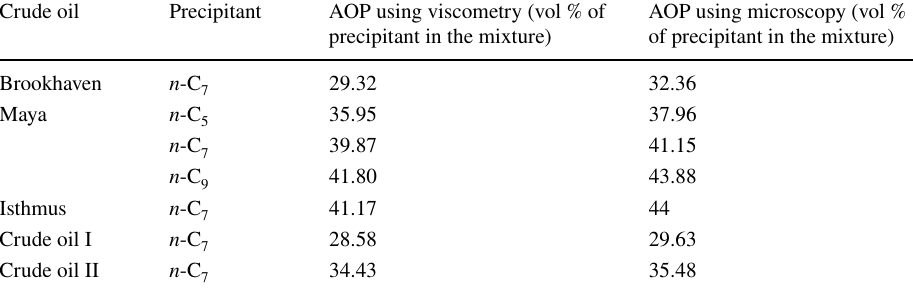
Table 2 Summary of viscometry and microscopy results to detect onset of asphaltene precipitation for various crude oils (Escobedo and Mansoori